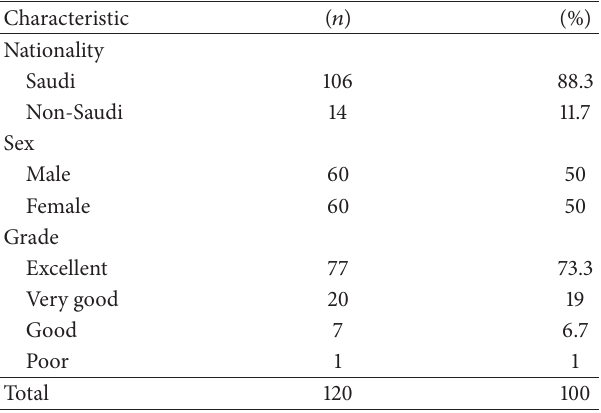
Table 1: Background characteristics of the students.